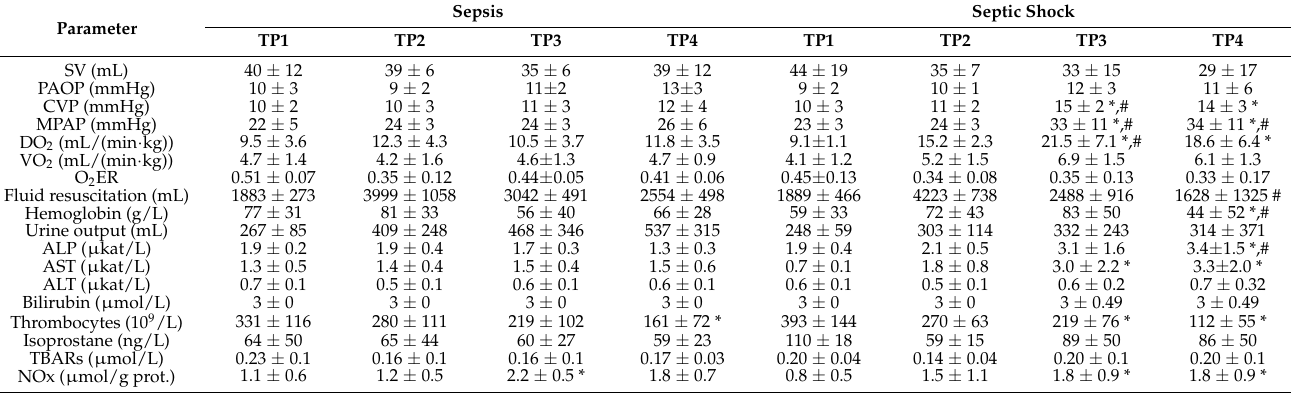
Table 1. Hemodynamical and biochemical parameters in sepsis and septic shock. SV: stroke volume, PAOP: pulmonary artery occlusion pressure, CVP: central venous pressure, MPAP: mean pulmonary artery pressure, DO 2 : oxygen delivery, VO 2 : oxygen consumption, O 2 ER: oxygen extraction ratio, ALP: alkaline phosphatase, AST: aspartate transaminase, ALT: alanine transaminase, TBARs: thiobarbituric acid reactive substances. NOx: nitrogen oxides. Mean ± SD; *, p < 0.05